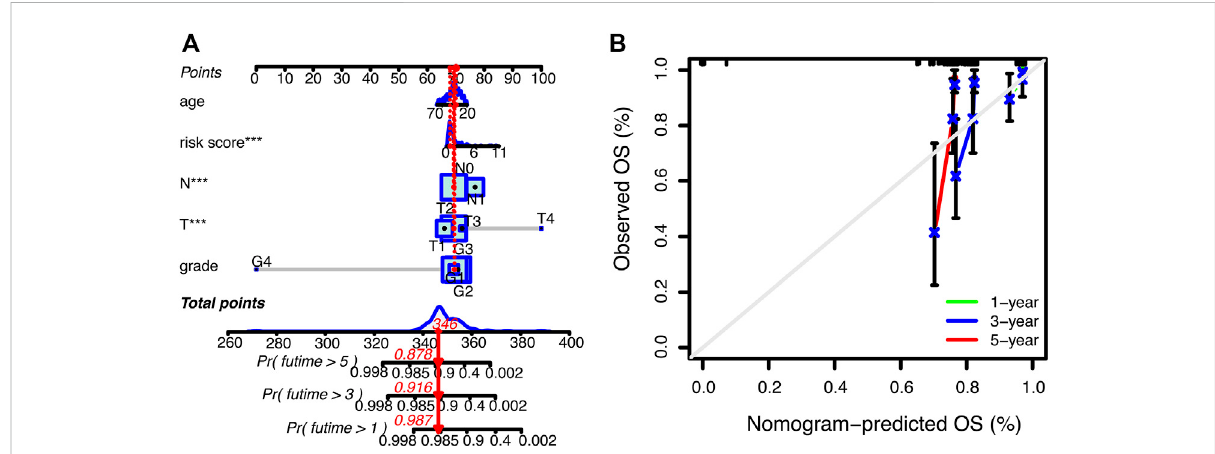
FIGURE 4 Nomogram for predicting overall survival (OS) in patients with cervical cancer. (A) Nomogram integrating signature, age, and tumor stage predicts the probability 1-year, 3-year, and 5-year OS. (B) Calibration curves for 1-year, 3-year, and 5-year OS.